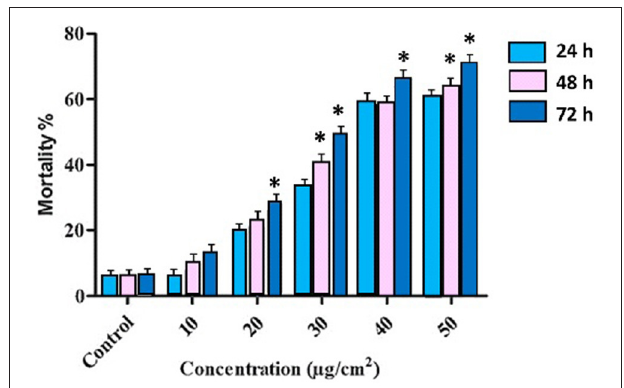
FIGURE 1 | Percentage of mortality rates of T. absoluta larvae (late 2nd instars) post ingestion of JHBP dsRNA through treated leaves. Mortality was positively correlated with dsRNA concentration and feeding access time period. The mortality is averaged across three trials each with three biological replicates. The three time-points, 24, 48, and 72h, were sampled across each dsRNA concentration treatment. One-way ANOVA followed by post-hoc Tukey’s multiple comparison test were completed. Error bars indicate standard errors of each mean values. Asterisk ( * ) shows statistically significant at various time intervals at different concentrations ( P < 0.05).